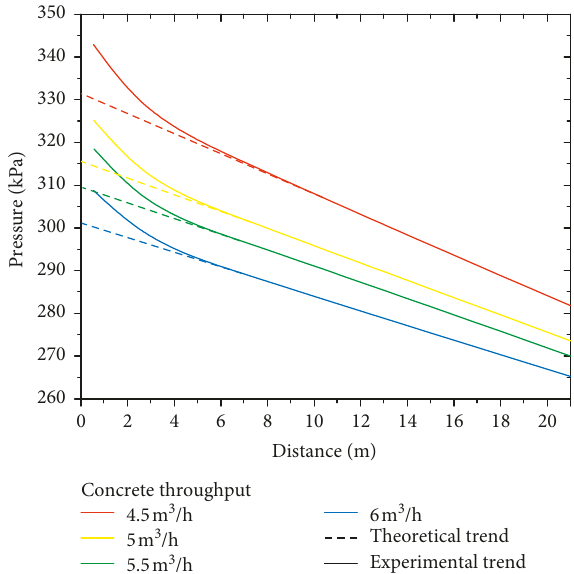
Figure 8: Variation trend of concrete pressure.